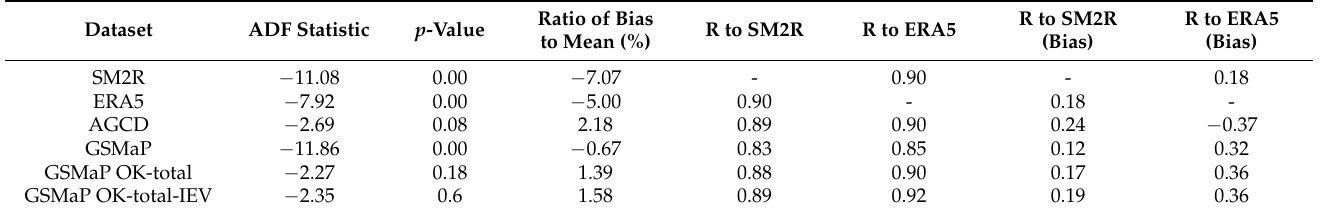
Table A1. Metrics testing whether the assumptions required for TCA are